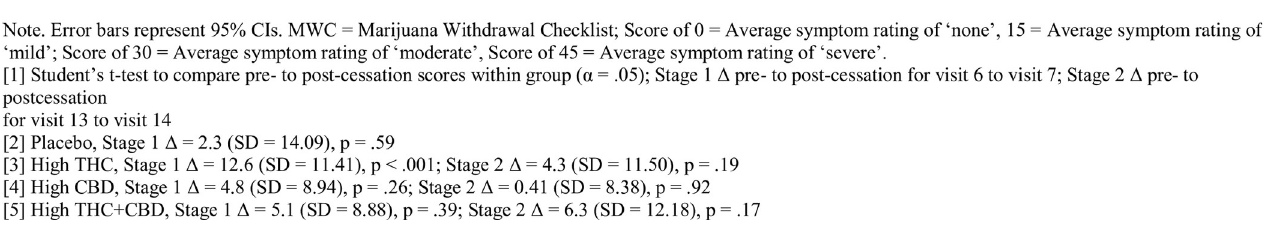
Fig 2. Mean total marijuana withdrawal scores by treatment condition across Stage 1 & Stage 2.